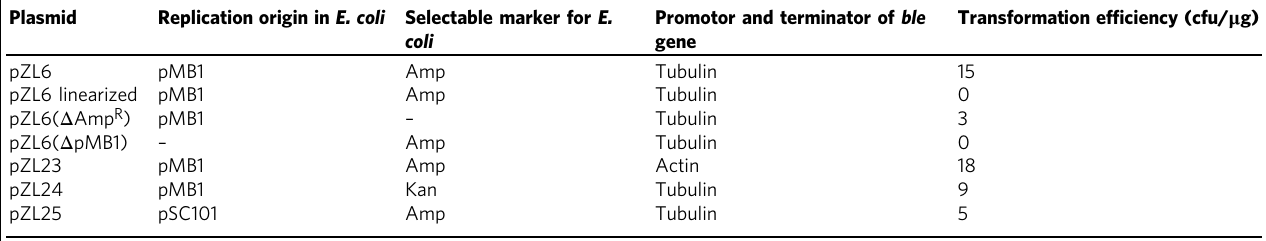
Table 1 Identi fi cation of the plasmid region that confers episomal replication in P. purpureum Plasmid Replication origin in E. coli Selectable marker for E.